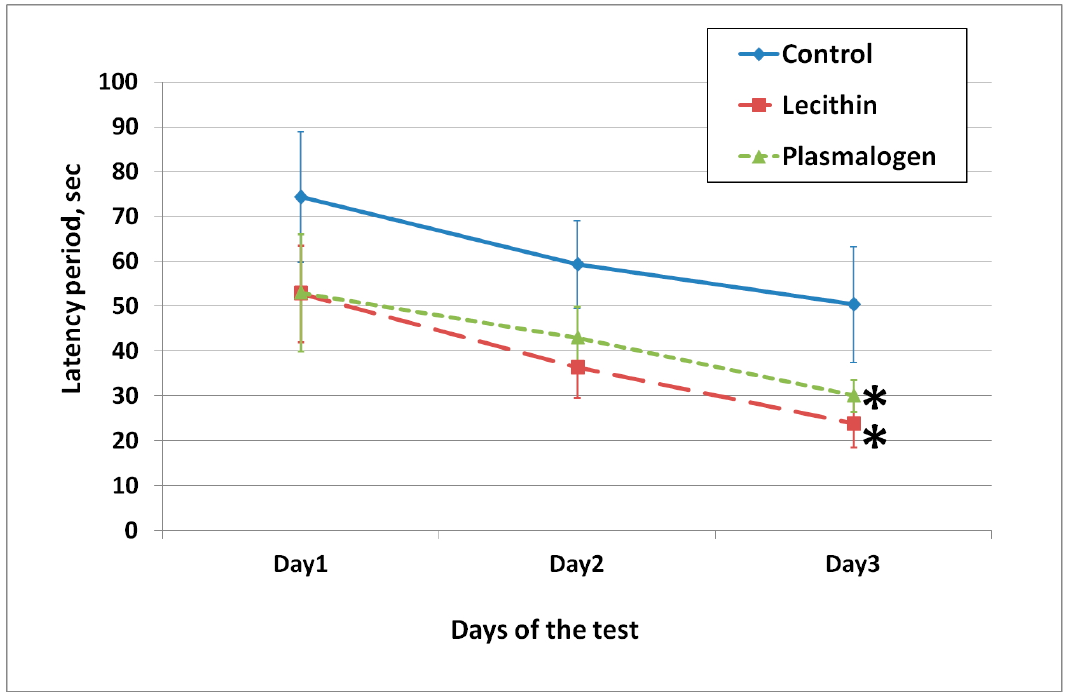
Figure 5. Average swimming time in Morris water maze. Values are mean ± SEM of 15 rats per group * one-way ANOVA p < 0.05 versus Control.